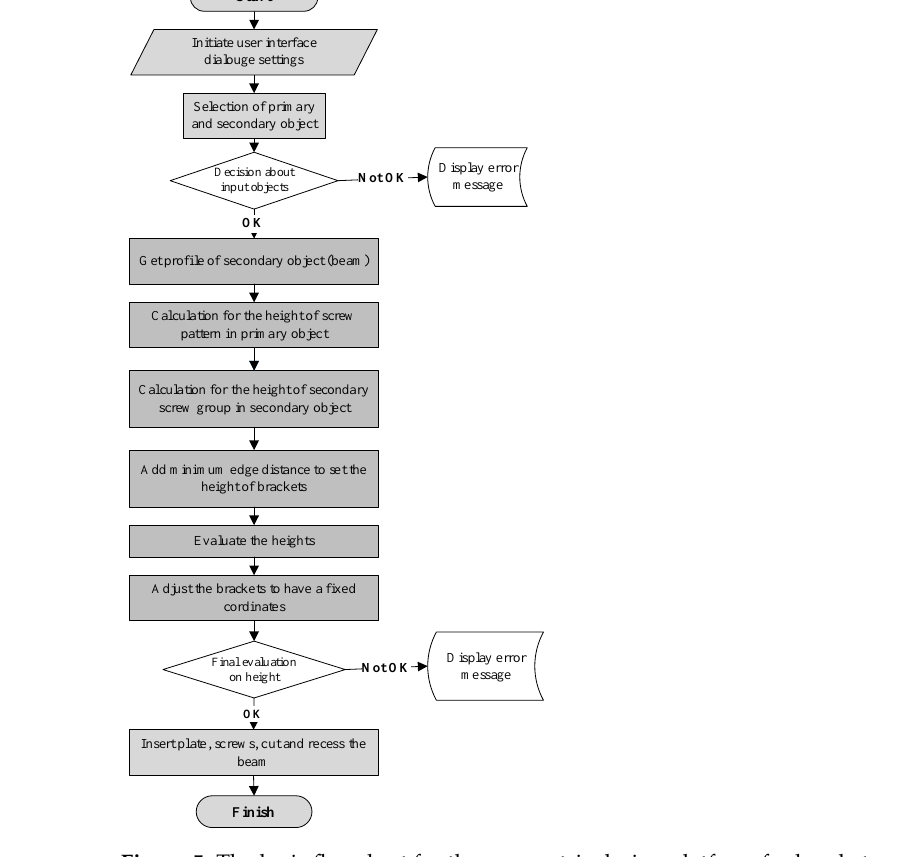
Figure 5. The logic flowchart for the parametric design platform for bracket connectors.